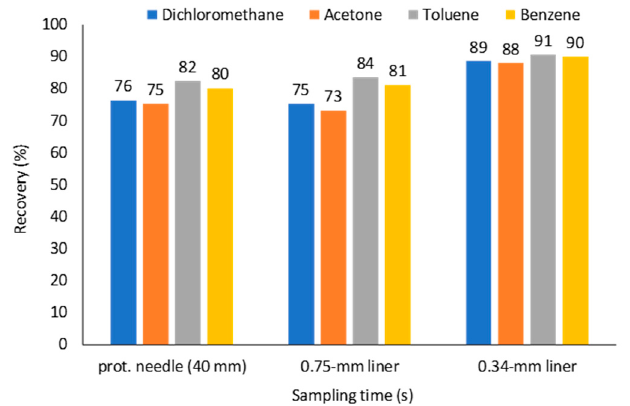
Figure 9. Effect of TWA SPME sampling geometry on recoveries ( t = 100,000 s, C 0–49,000 s = 1.176 μ mol · m − 3 , C 49,000–51,000 s = 1.176–0.1176 μ mol · m − 3 , C 49,000–100,000 s = 0.1176 μ mol · m − 3 ).